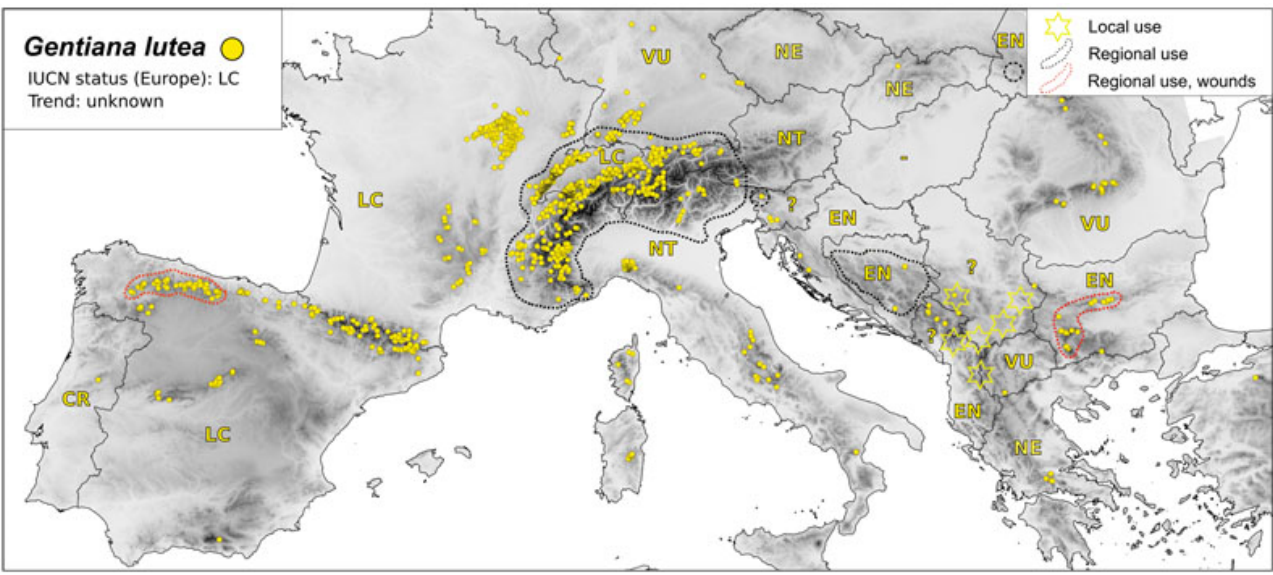
Figure 2. Map of distribution of G. lutea —conservation status and medicinal use, Legend: IUCN status—Least Concern (LC); Near Threatened (NT); Vulnerable (VU); Endangered (EN); Critically Endangered (CR); and Not Evaluated (NE).